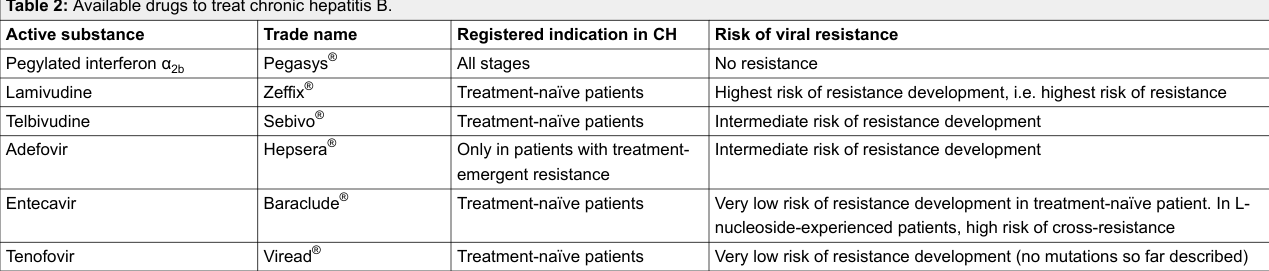
Table 2: Available drugs to treat chronic hepatitis